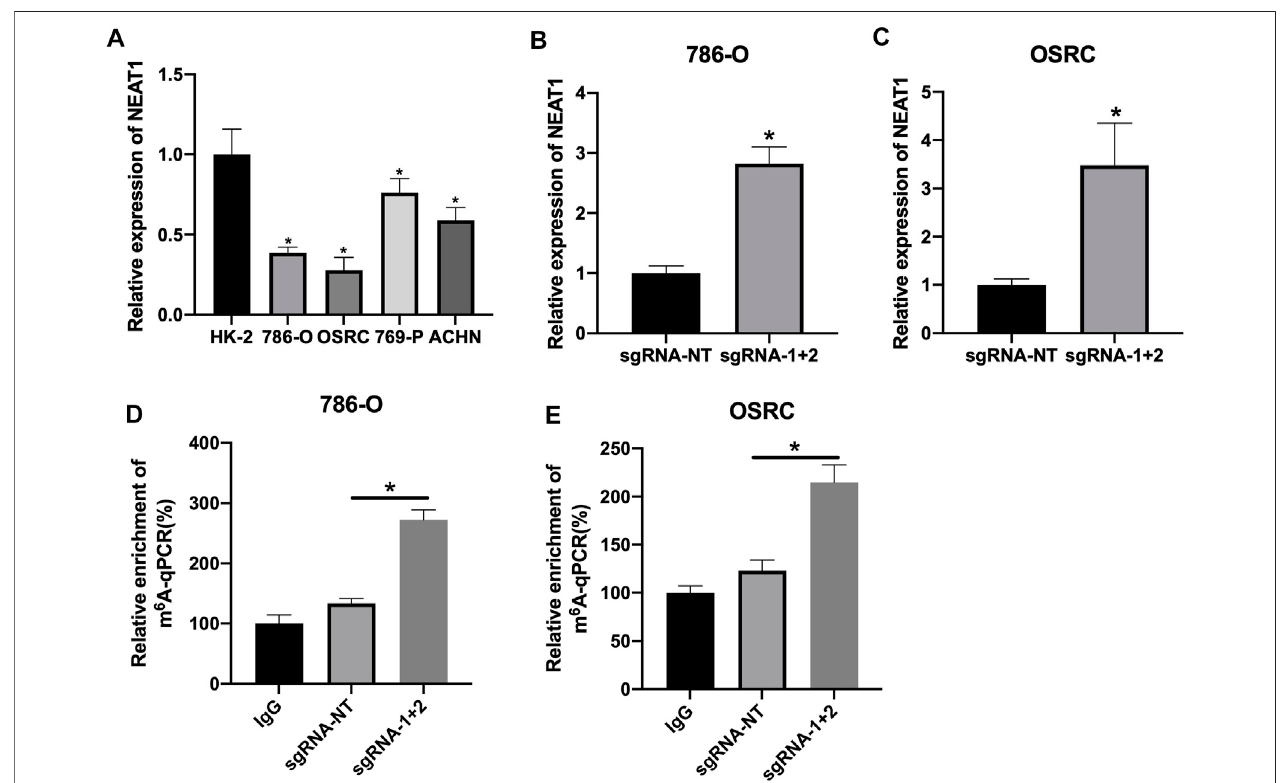
FIGURE 2 | CRIPSR/dCas13b-METTL3 increased the expression level of LncRNA NEAT1 in RCC cells . (A) The mRNA levels of LncRNA NEAT1 in RCC cell lines (786-O, 769-P, ACHN and OSRC) and normal renal cell (HK2) detected by RT-qPCR. (B,C) The mRNA levels of LncRNA NEAT1 in 786-O cells (B) and OSRC cells (C) after transfected with dCas13b-METTL3 and sgRNAs for 24 h detected by RT-qPCR. (D,E) The m6A levels of LncRNA NEAT1 in 786-O cells (D) and OSRC cells (E) after transfected with dCas13b-METTL3 and sgRNAs for 24 h detected by MeRIP-qPCR. * p < 0.05.